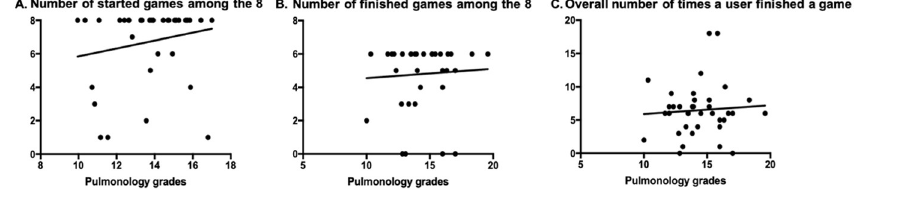
Fig 4. Correlations between the grades in pulmonology and students’ assiduity parameters when the exam subject was covered by Chatprogress.